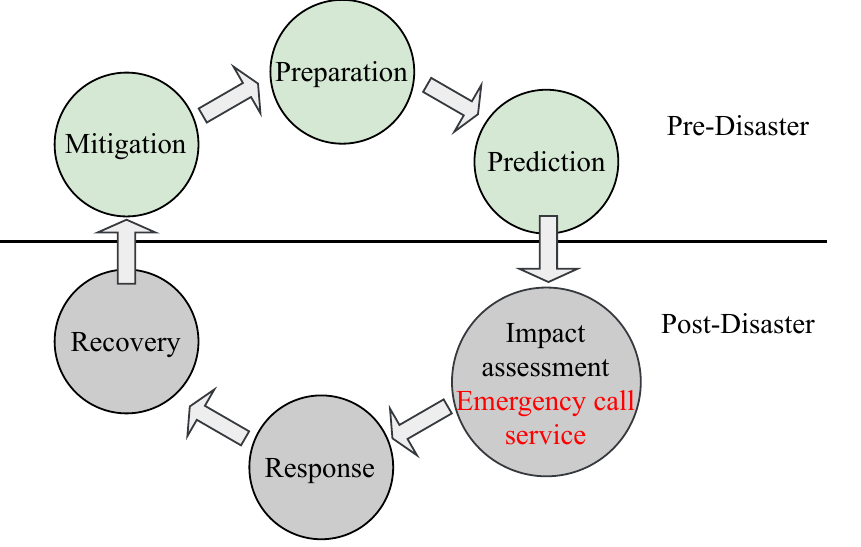
Figure 1. The phases of disaster management cycle during pre-disaster and post-disaster stages.